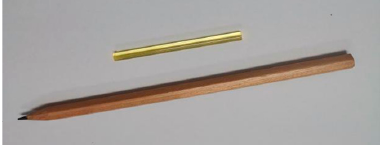
Figure 1. Yb 2+ -doped silica glass